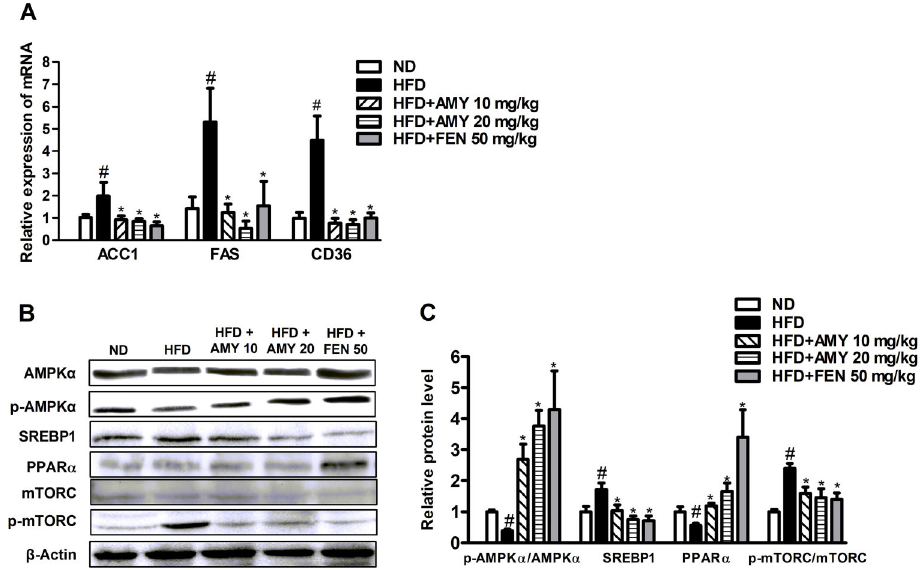
Figure 4. Effects of a , b -amyrin (AMY) on key molecules in liver lipid metabolism in HFD-induced nonalcoholic fatty liver disease in mice. A , RT-qPCR analyses of hepatic mRNA levels of genes involved in lipogenesis (ACC1 and FAS) and fatty acid uptake (CD36). B and C , Hepatic levels of proteins involved in energetic homeostasis (AMPK), lipogenesis (SREBP1 and mTORC), and beta oxidation (PPAR a ). Data are reported as means ± SE (n=8). # P o 0.05 vs ND-fed animals; *P o 0.05 vs HFD-fed animals (ANOVA followed by the Student- Newman - Keuls test). ND: normal diet; HFD: high-fat diet; FEN: feno fi